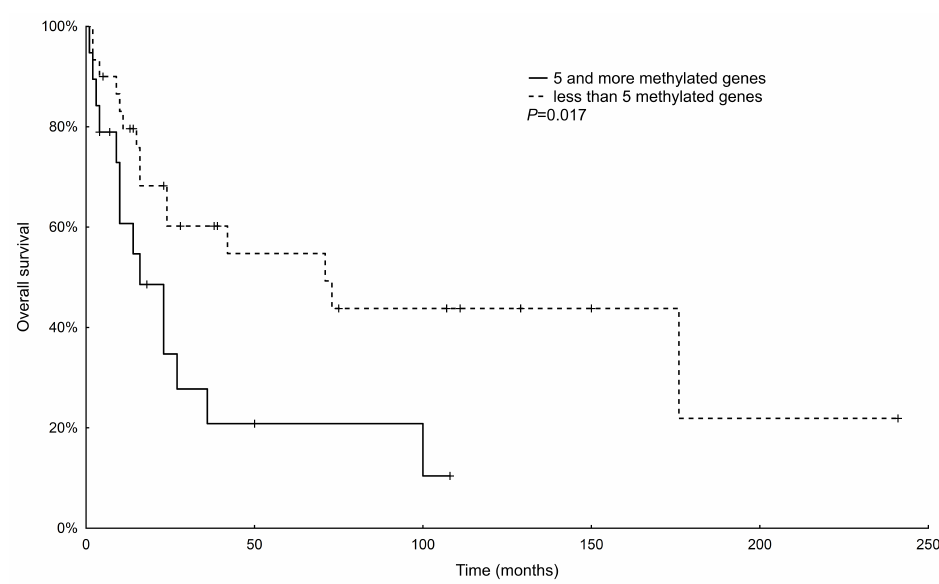
Fig. 2. Kaplan-Meier survival analysis. Overall survival of patients according to the presence of methylation. Vertical hatch marks show censored